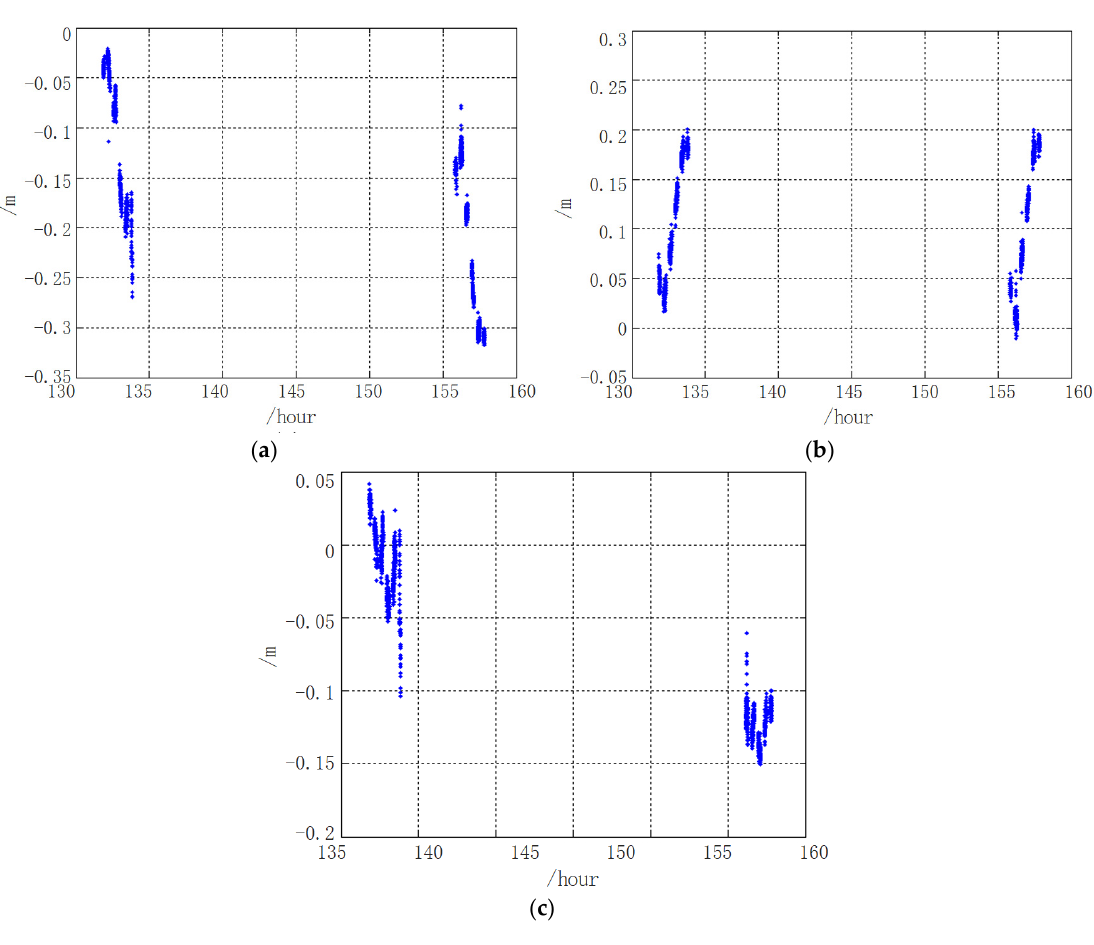
Figure 17. Orbit accuracy review with cross ‐ support DeltaDOR measurement. ( a ) Baseline CEB ‐ NNO; ( b ) baseline CEB ‐ KSH; ( c ) baseline NNO ‐ KSH.